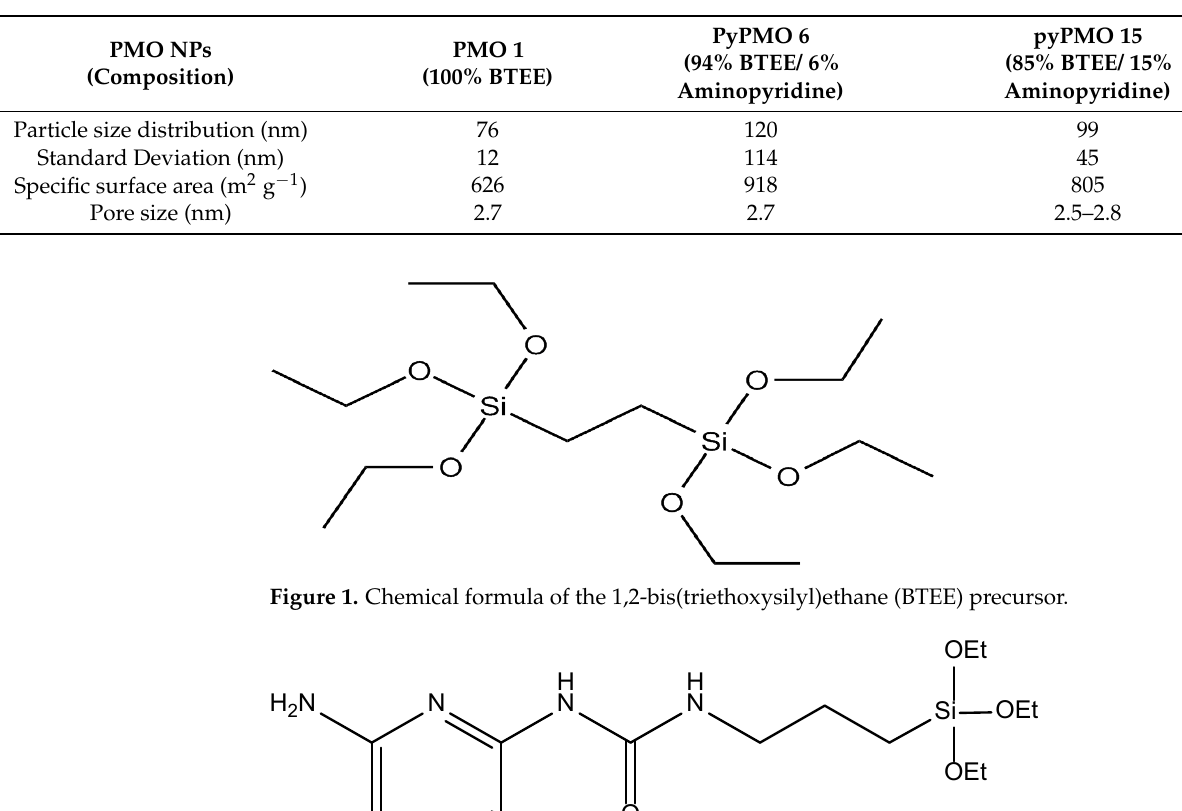
Table 1. Size distribution, standard deviation values of PMO 1 NPs, pyPMO NPs, analyzed from TEM, specific surface area and pore sizes of PMO 1 NPs, pyPMO NPs analyzed from N 2